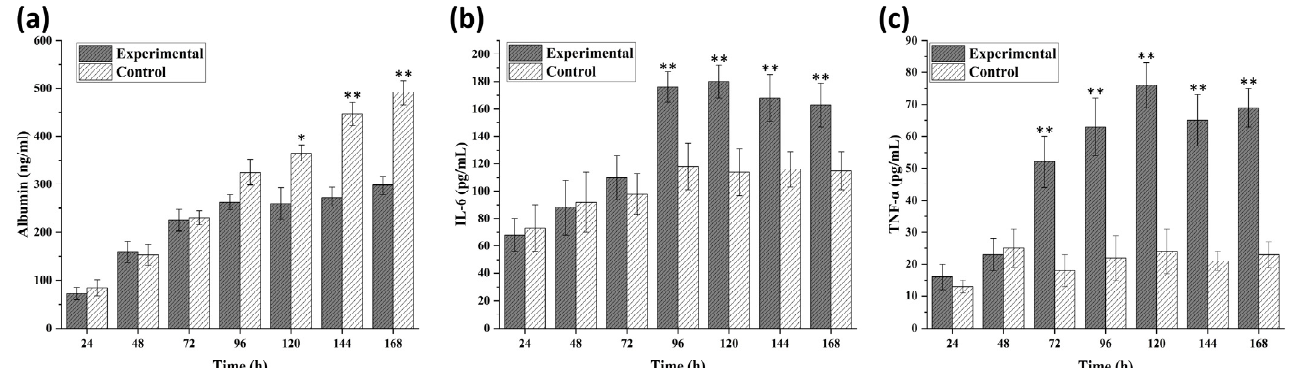
Figure 7. ELISA-based biomarkers quantification for disease model spheroids cultured in media with 20 ng/mL IL-1 β (stimulant) versus control spheroids cultured with normal media (no stimulant) was performed after each interval of 24 h. Albumin ( a ), IL-6 ( b ), and TNF- α ( c ) were measured until one week to analyze the development of the inflammatory disease model under the influence of IL-1 β . The results indicated the successful development of inflammation from Day 3. Data are shown as mean ± SEM. * p ≤ 0.05 versus control; ** p ≤ 0.01 versus control.